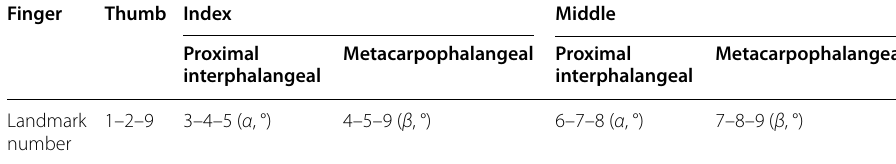
Table 2 Landmark numbers for the 3D scanning measurement of angles Finger Thumb Index Middle Proximal Metacarpophalangeal Proximal Metacarpophalangeal interphalangeal interphalangeal Landmark